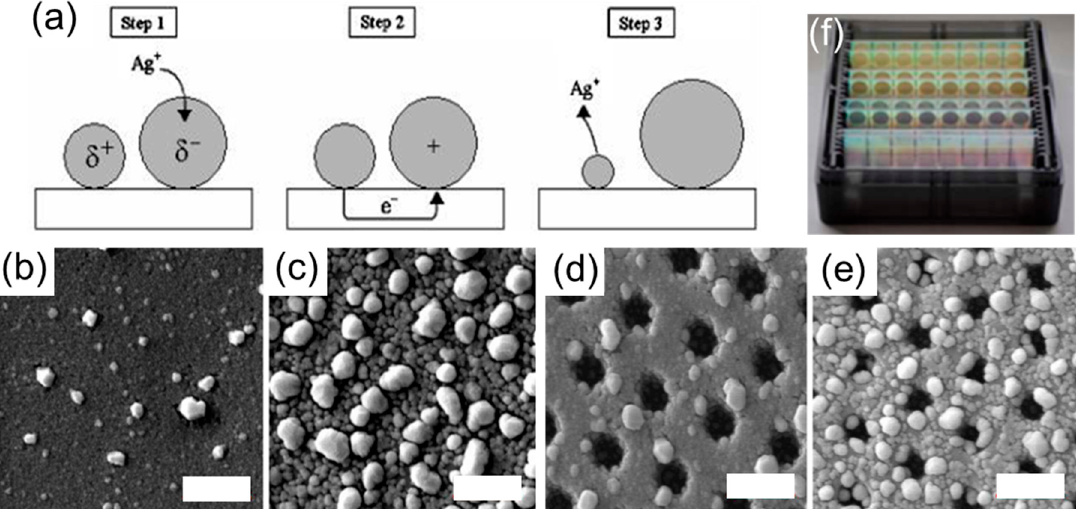
Figure 5. Electrochemical Ostwald ripening . ( a ) Schematic showing the reduction of Ag + on the large NPs followed by the electron transfer from the small to the large NPs and the oxidation of Ag(0) NP into Ag + . ( b − e ) SEM images showing the morphology of a sputtered Ag film on polymeric substrates with flat surfaces ( b , c ) and microstructured surfaces ( d , e ) after being incubated in an acidic aqueous solution for 1 min ( b , d ) and 100 min ( c , e ). ( b − e ) Scale bars are 1 micron. ( f ) Photograph of SERS substrates prepared via injection molding and Ostwald electrochemical ripening of a sputtered Ag film, leading to a nanostructured Ag surface such as the one shown in ( e ). ( a ) Reprinted with permission from ref. [67]. Copyright 2005 American Chemical Society. ( b − f ) Reprinted with permission from ref. [70] Copyright 2017 American Chemical Society.